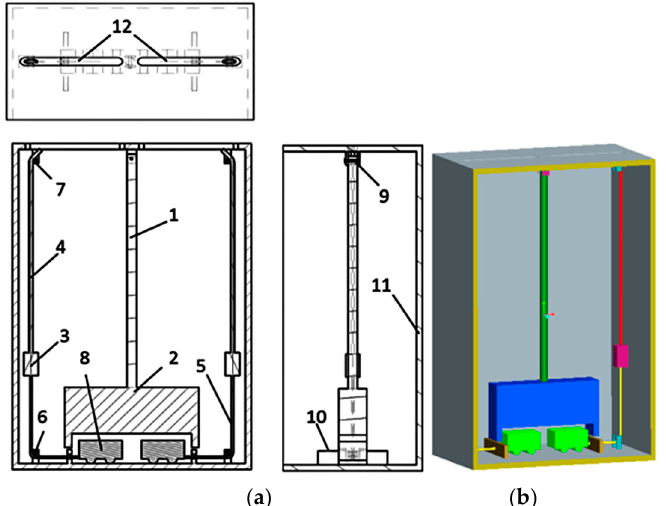
Figure 2. SMA-SPDS structure diagram. ( a ) Construction details. ( b ) Three-dimensional structure. 1—Pendulum rod; 2—Mass vibrator; 3—Wire conversion joint; 4—Steel cable; 5—SMA; 6—Bottom steering pulley; 7—Upper steering pulley; 8—The small car; 9—One-way hinge; 10—Baffle; 11—The shell; 12—Steel cable channel.